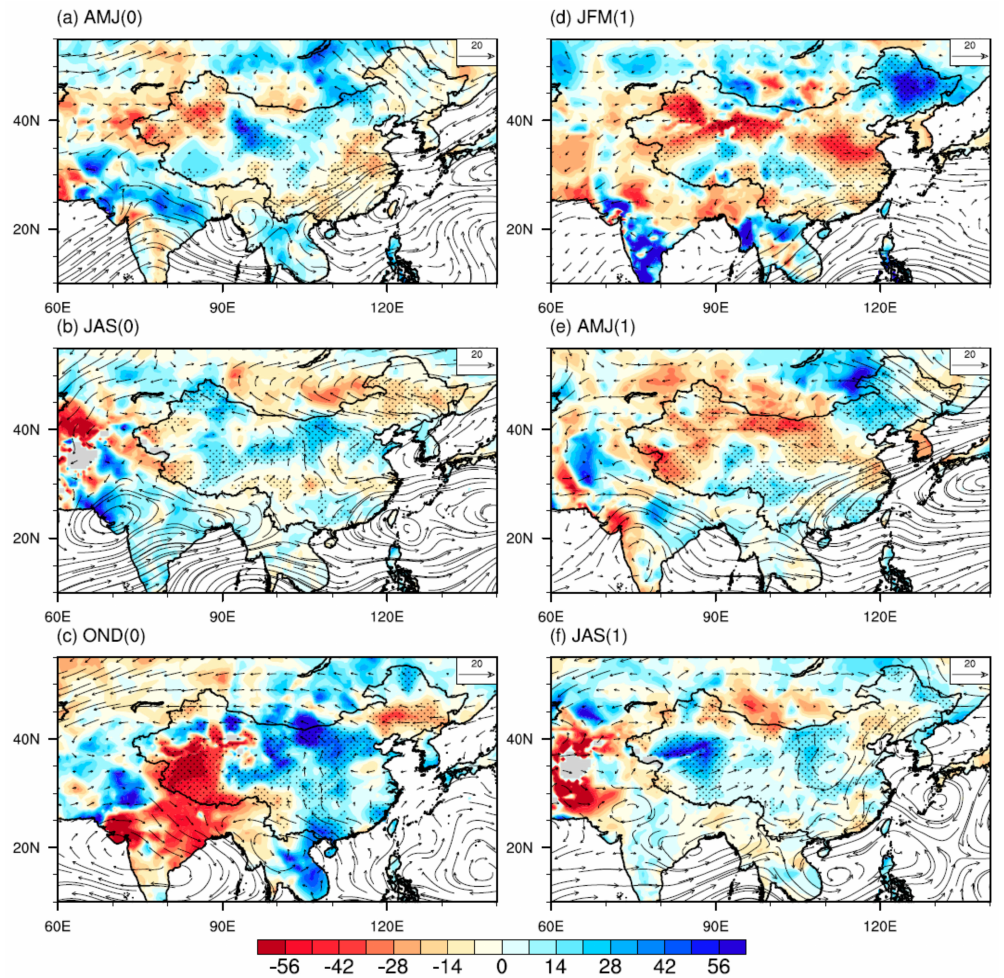
Figure 5. Same as in Figure 3, but for the pure positive IOD years when the Indian Ocean SST dipole occurred in the non-El Nino years. Shown are during ( a ) April to June (AMJ(0)), ( b ) July to September (JAS(0)), and ( c ) October to December (OND(0)) in the developing phase, and the following ( d ) January to March (JFM(1)), ( e ) April to June (AMJ(1)), and ( f ) July to September